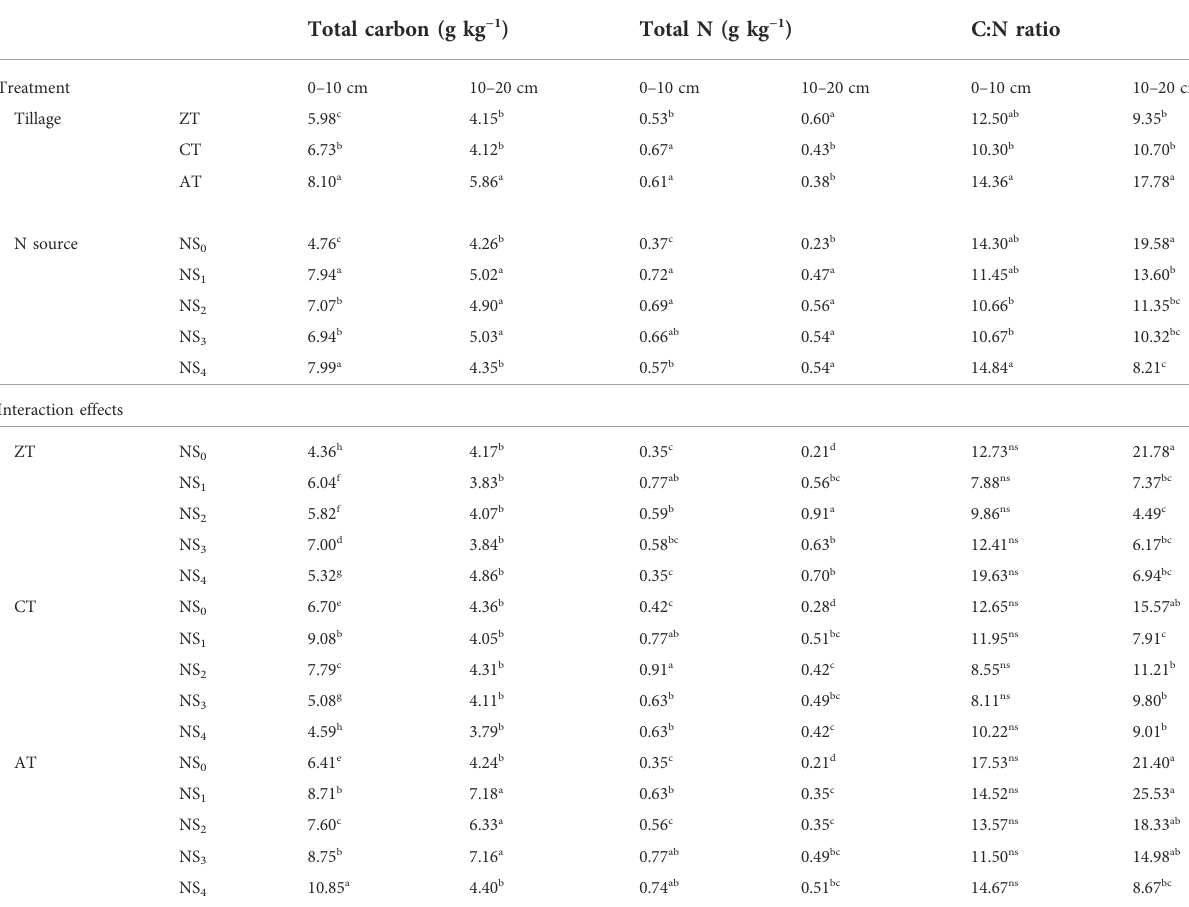
TABLE 3 Effects of tillage practices and N sources on the total carbon (SOC; g · kg − 1 ), total N (TN; g · kg − 1 ), and the C:N ratio in soil at the end of the experiment. Main and Sub-plots effect